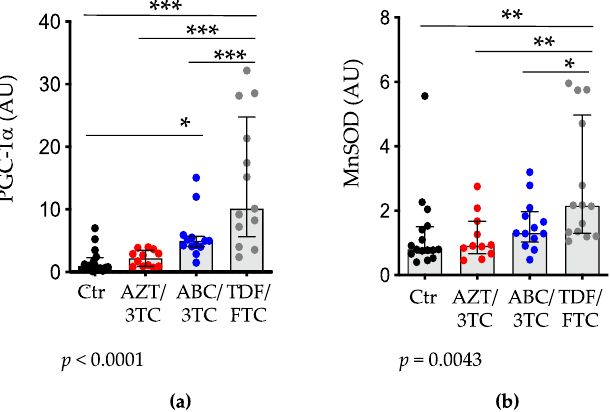
Figure 5. Placental mRNA levels of PGC-1 α and MnSOD are elevated in pregnant mice treated with TDF/FTC. Placental mRNA expression levels of ( a ) PGC-1 α and ( b ) MnSOD of mice treated with AZT/3TC (red dots), ABC/3TC (blue dots), TDF/FTC (grey dots), or water (control; black dots). Data are scatter dot plots with median and interquartile range (n = 16 placentas from 6 litters for control; n = 11–12 placentas from 6 litters for AZT/3TC; n = 12–13 placentas from 5 litters for ABC/3TC; n = 13–14 placentas from 6 litters for TDF/FTC). Statistical comparisons by mixed-effects modelling to control for litter effects (using treatment as a fixed effect and litter as a random effect). * = p < 0.05, ** = p < 0.01, *** = p < 0.001. The p -values below the panels are for the model. AZT, zidovudine; 3TC,